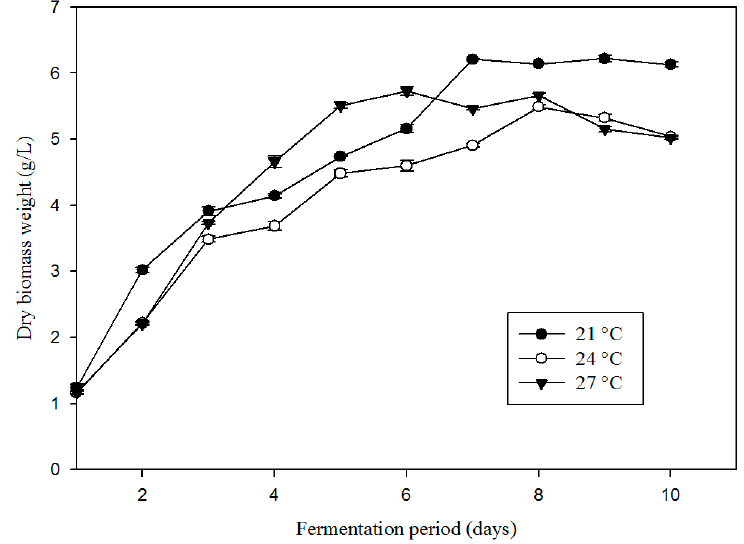
Figure 1. Compared effects of culture at three different temperatures (21, 24, and 27 °C) on biomass growth for T. albobiverticillius 30548 (culture in PDB, initial pH 4.0, 200 rpm of agitation rate).